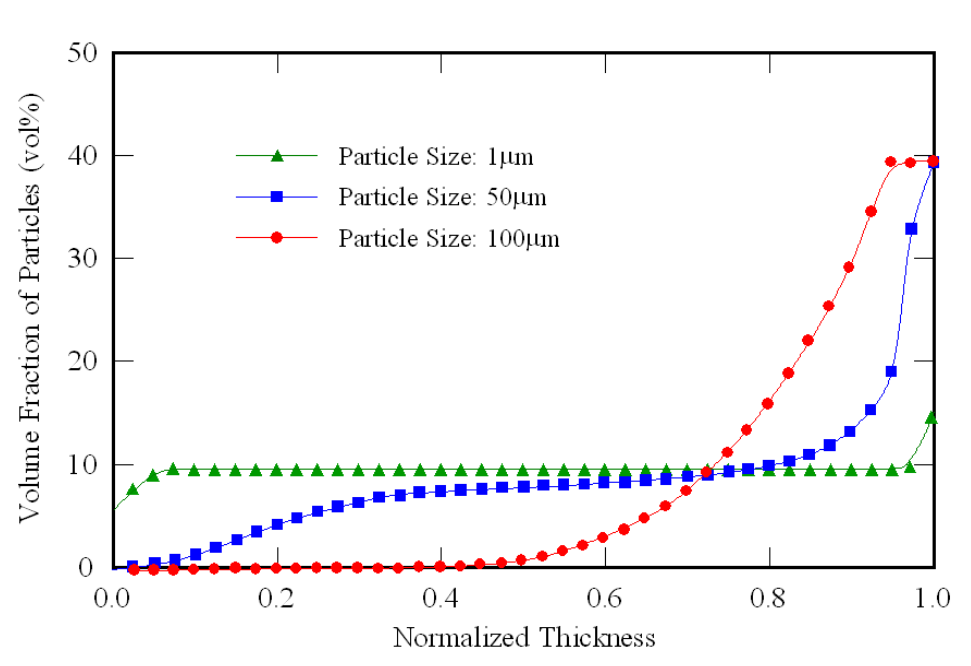
Figure 2. Particle distribution in an FGM fabricated by centrifugal solid-particle method